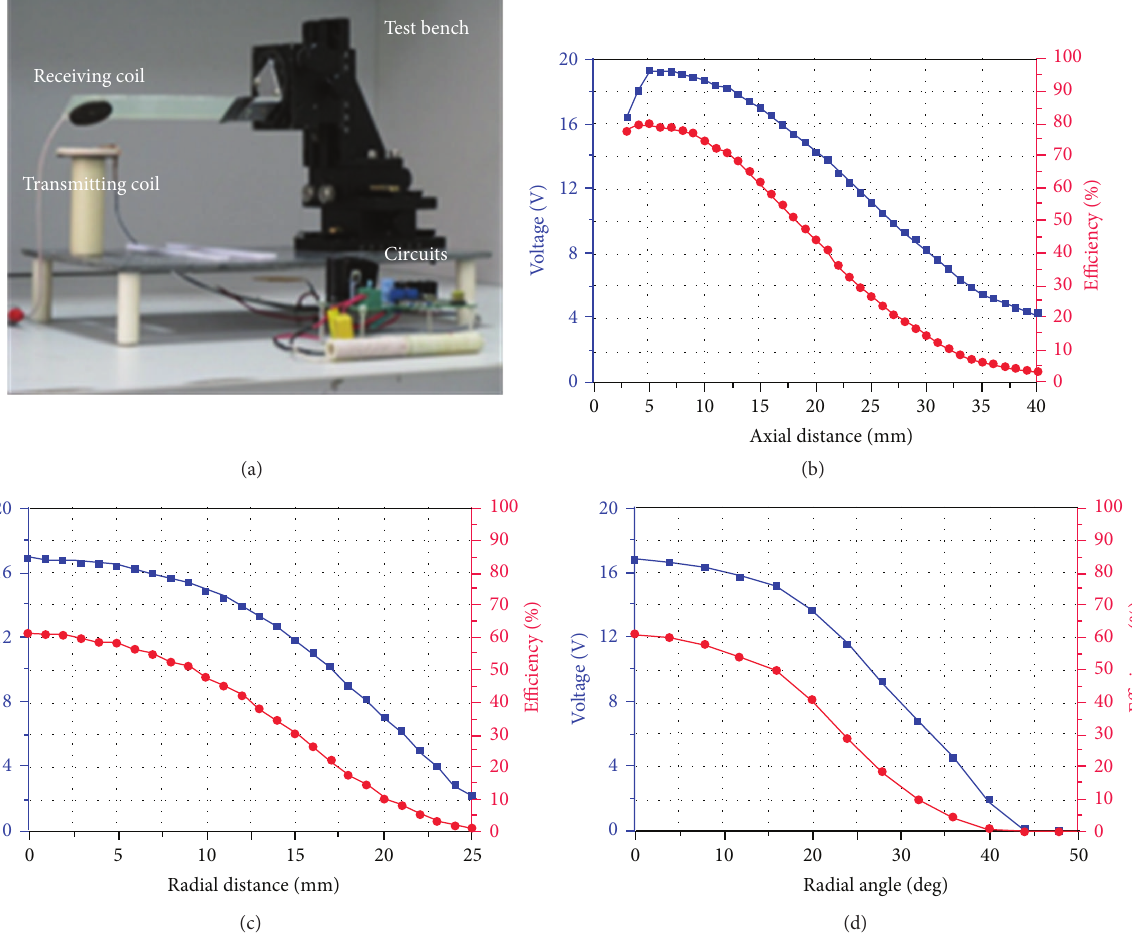
Figure 5: Test of transcutaneous power supply system. Test bench (a) and results in axial distance (b), radial distance (c), and radial angle